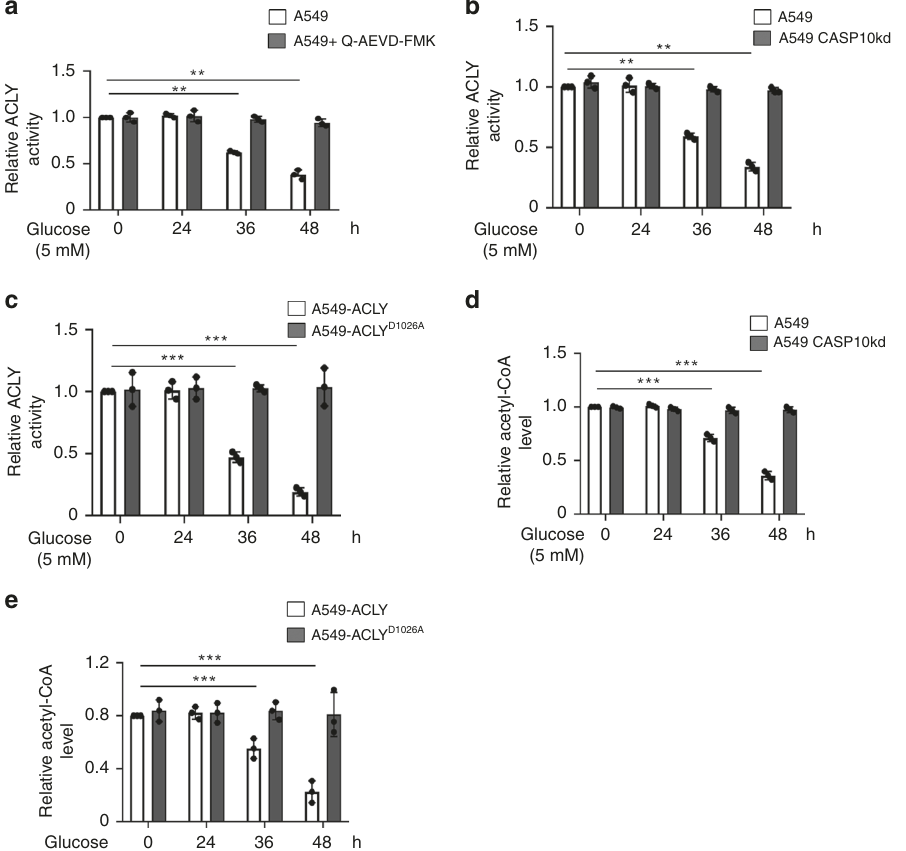
Fig. 3 Caspase-10 regulates nucleocytosolic acetyl-CoA levels a A549 cells were subjected to glucose starvation and concomitantly treated with